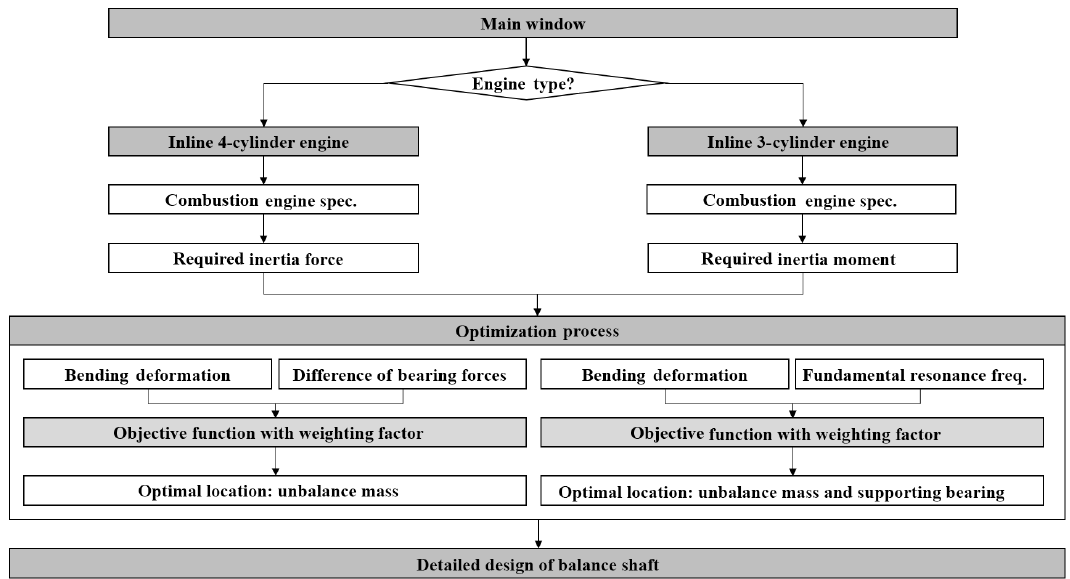
Figure 10. Flow chart of balance shaft